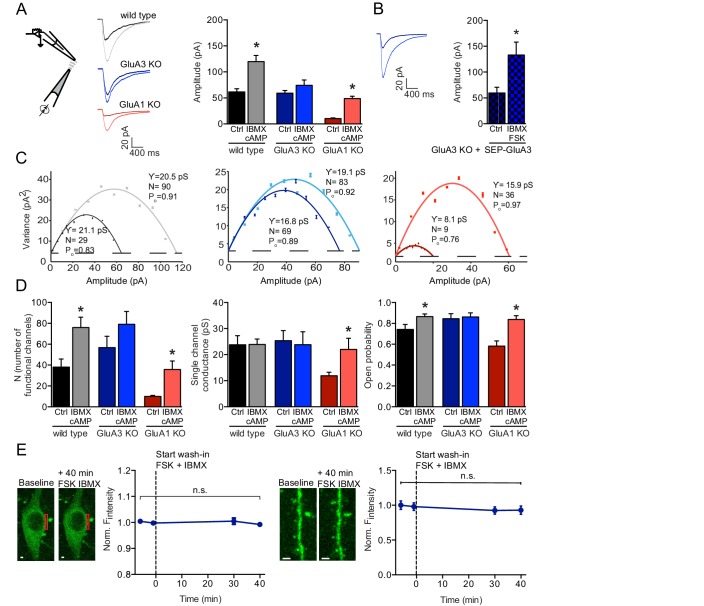
cAMP increases currents of extrasynaptic GluA3-containing AMPARs.(A) Experimental setup, example traces and averages of AMPAR amplitudes in response to AMPA puffs onto outside-out patches from WT CA1 cell bodies without (black; n=15) or with (gray; n=24) cAMP in pipette, GluA3-KO without (dark blue; n=20) or with (light blue; n=20) cAMP, and GluA1-KO without (dark red; n=18) or with (light red; n=10) cAMP. Wild type and GluA1-deficient neurons showed an increased amplitude upon AMPA puffs in the presence of cAMP in the recording pipette, GluA3-deficient did not (t-test, WT: p=0.0009; t-test, 3KO: p=0.9; t-test, 1KO: p<0.0001). All recordings in the presence of desensitization blockers cyclothiazide and PEPA and cAMP condition in the presence of PDE inhibitor IBMX. (B) Outside-out patches from SEP-GluA3 infected GluA3-KO cell bodies, before (n=7) and after (n=8) wash-in of forskolin plus IBMX. Sindbis expression of SEP-GluA3 in GluA3-KO neurons rescues GluA3-dependent plasticity (t-test, p=0.03). (C) Example graphs of non-stationary noise analysis for WT, GluA3-KO and GluA1-KO outside-out recordings. (D) Average number of functional channels, single channel conductance and open probability extracted from non-stationary noise analysis of the outside-out recordings from WT (ctrl: n=14; FSK/IBMX: n=16), GluA3-KO (ctrl: n=10; FSK/IBMX: n=11), or GluA1-KO (ctrl: n=8; FSK/IBMX: n=7) CA1 neurons (see methods). Upon forskolin and IBMX GluA1-deficient neurons show an increased number of functional channels (t-test, p=0.0009), single channel conductance (t-test, p=0.04) and open probability (t-test, p=0.002). (E) Example images and average fluorescence intensity of GluA3-KO cell bodies (left; n=10) and dendrites (right; n=12) infected with SEP-GluA3 visualized with 2-photon laser scanning microscopy before and after wash-in of forskolin plus IBMX shows no change in SEP levels (dendrite: t-test, p=0.4; cell bodies: t-test, p=0.﻿2). Scale bars indicate 5 μm. Error bars indicate SEM, * indicates p<0.05.